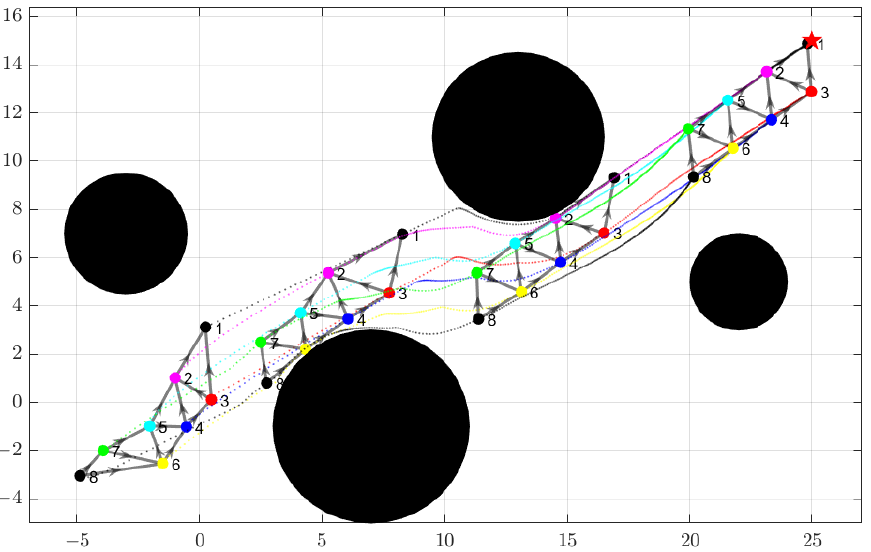
Figure 8. Eight robots navigate in a known environment with sparse obstacles. The red star stands for the target position of leader. Solid black circles denote obstacles of different sizes. Eight small colored circles represent robots. The sensing topologies at t = 0,0.8,2.4, and 10 s are plotted from left lower to right upper and the dotted line represents the trajectories of four